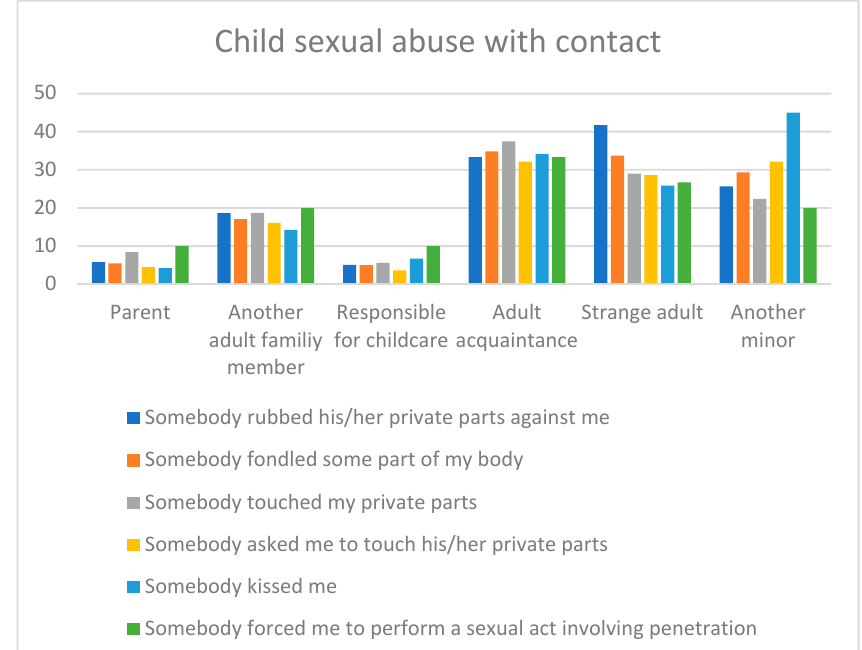
Figure 1. Age at the first episode as a function of the type of CSA with contact.